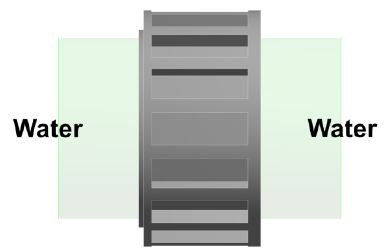
10 Figure 7. Whole open-eco-innovation process with KET TCs, SMEs, and EENs. 2.2. Example of Application for an Open-Eco-Innovation Process This section shows an example of an eco-open-innovation project carried out with an SME and a KET TC. In this case the SME was found by an EEN partner during the dissemination of the KET4CP project and was accompanied until the TR preparation. Therefore, the importance of the processes to be followed until the TR preparation is clear. Knot Ltd. (SME) (Auckland, New Zealand) wished to develop an innovative water turbine which can be fitted within the water piping network to harness electricity owing to loss of potential energy and deliberate velocity reduction in off-peak times. Such turbines need to be developed and manufactured with the highest possible functionality. However, the SME lacked some of the competencies required to design and manufacture an adequately optimised turbine. Specialised in water monitoring and sensor systems, the SME had no experience with simulations. Through the direct contact of an EEN Partner the SME received the information about KET4CP. Accompanied by the EEN partner the SME submitted a TR with its idea and the problem. Different sizes and models of turbines were planned by the SME in order to implement the turbine for various applications involving city water pipes or rainwater harvesting drains to name a few. A simulation model was, therefore, set up through this project by Hahn-Schickard (KET TC) to analyse the functionality of such a turbine. This developed simulation model provides a basis for